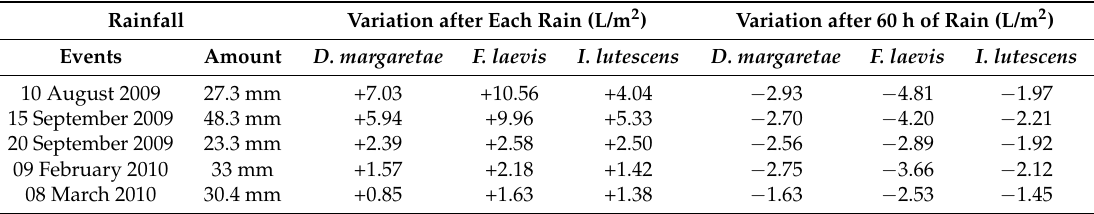
Table 2. Variation of substrate water content after different rainfall events (volumetric water content (VWC) before–VWC after) and between field capacity and 60 h after the rainfall events in each species. Rainfall Variation after Each Rain (L/m 2 ) Variation after 60 h of Rain (L/m 2 ) Events Amount D. margaretae